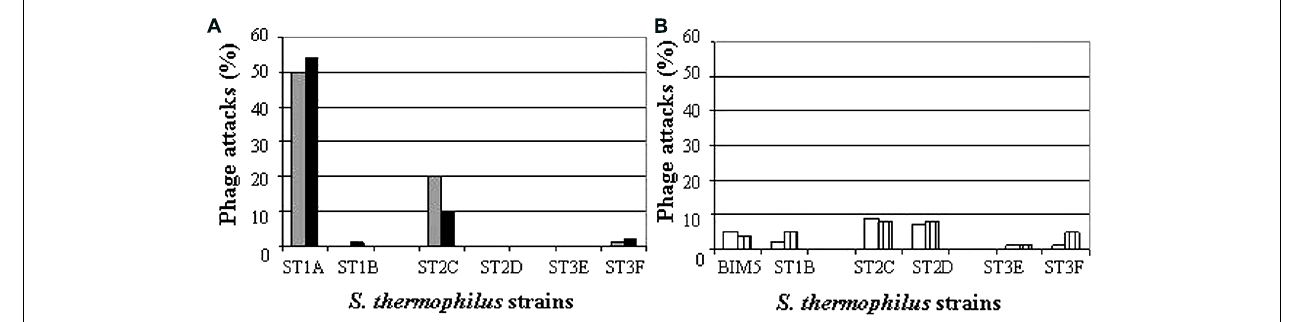
whey sample. A delay in growth rate of a strain by the addition of whey was considered as a phage attack. (A) , whey samples collected during the years 2009 (grey) and 2010 (black); (B) , whey samples collected during the years 2011 (white) and 2012 (vertical line pattern) .